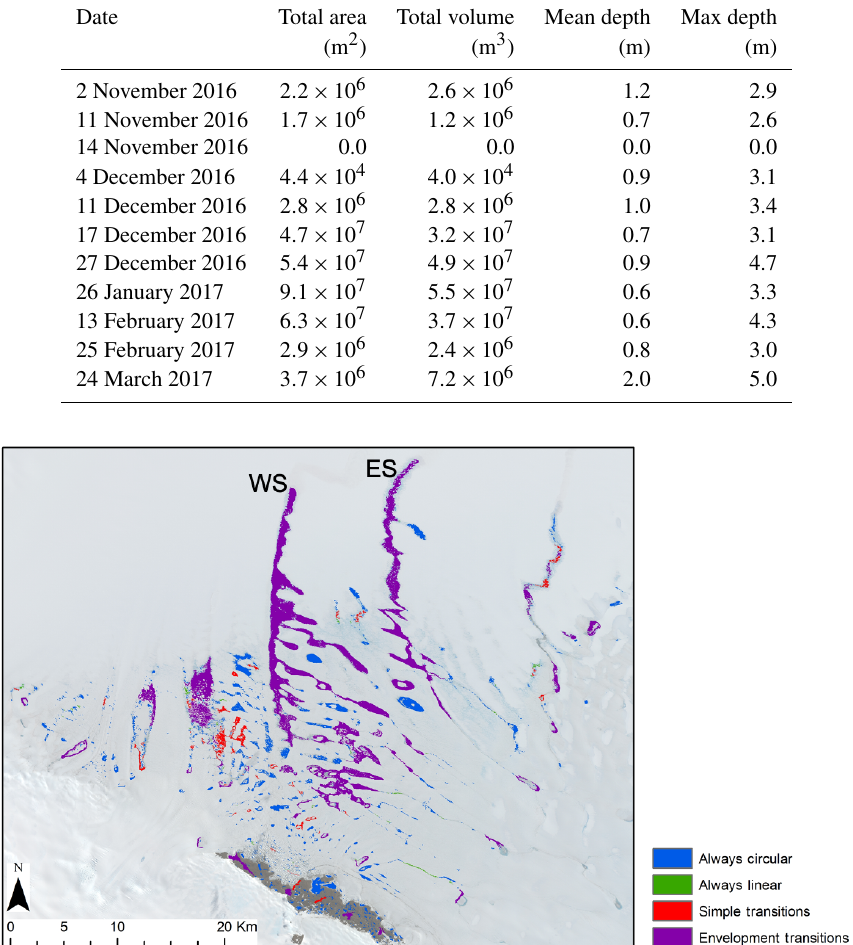
Figure 6. Maximum extent of all identified water bodies on the Nivlisen Ice Shelf for the 2016–2017 melt season, colour coded by water body type. “WS” denotes “western system”, and “ES” is eastern system. Base image acquired by Sentinel-2 on 26 January 2017.